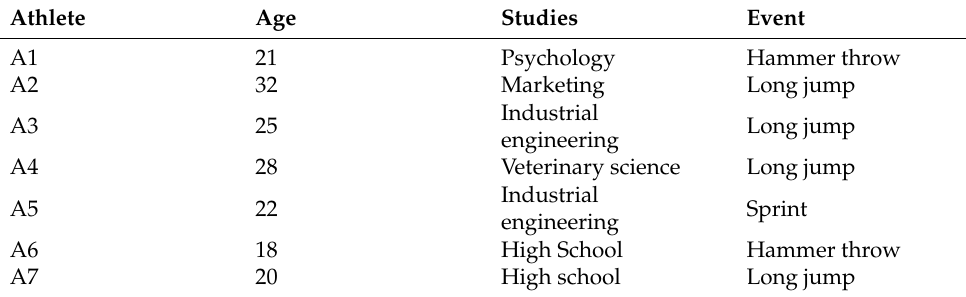
Table 1. Demographic details of